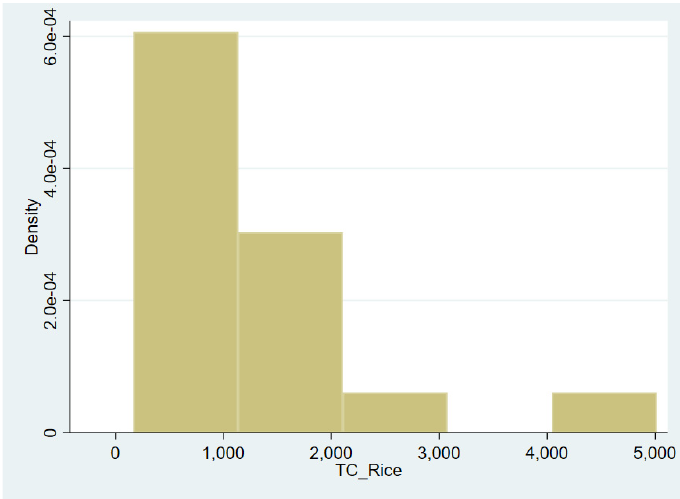
Figure 3. Numerical transaction costs in contracts (N = 191) .